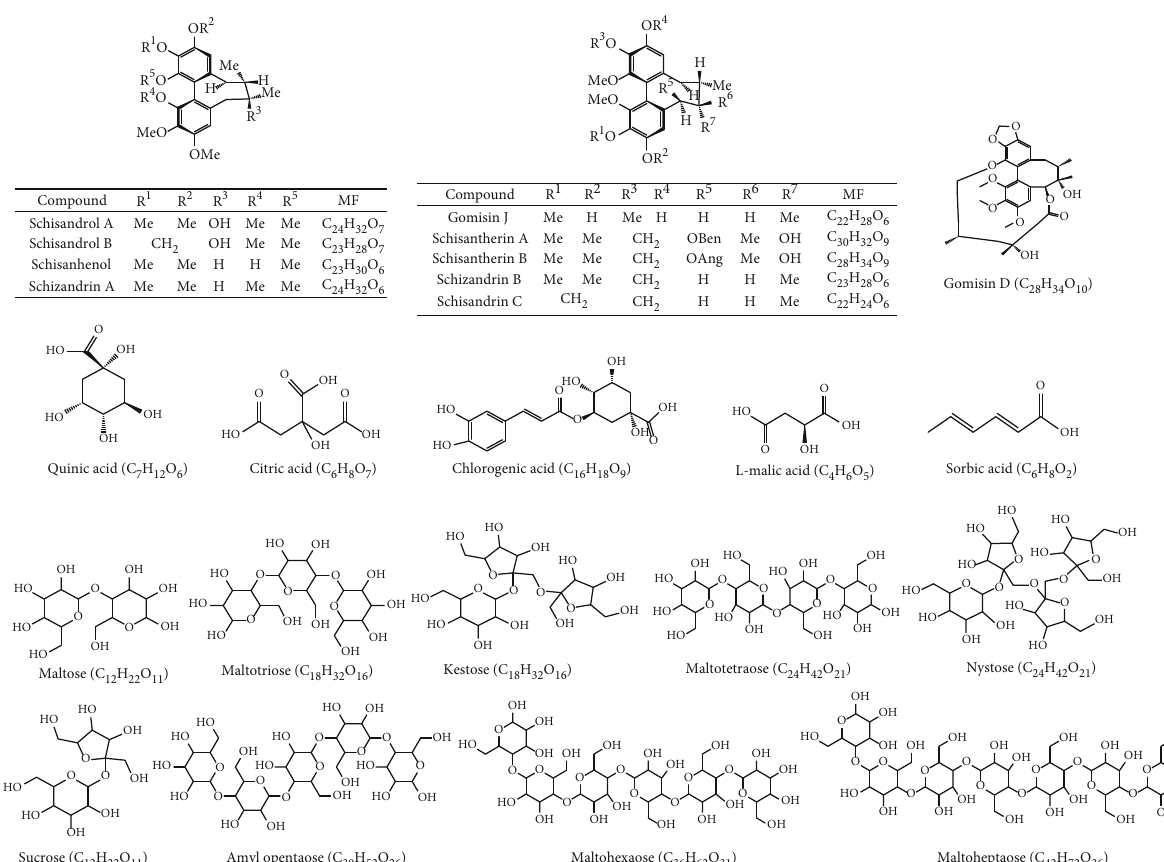
Figure 1: Structures of lignans, organic acids, and oligosaccharides detected in Schisandra chinensis